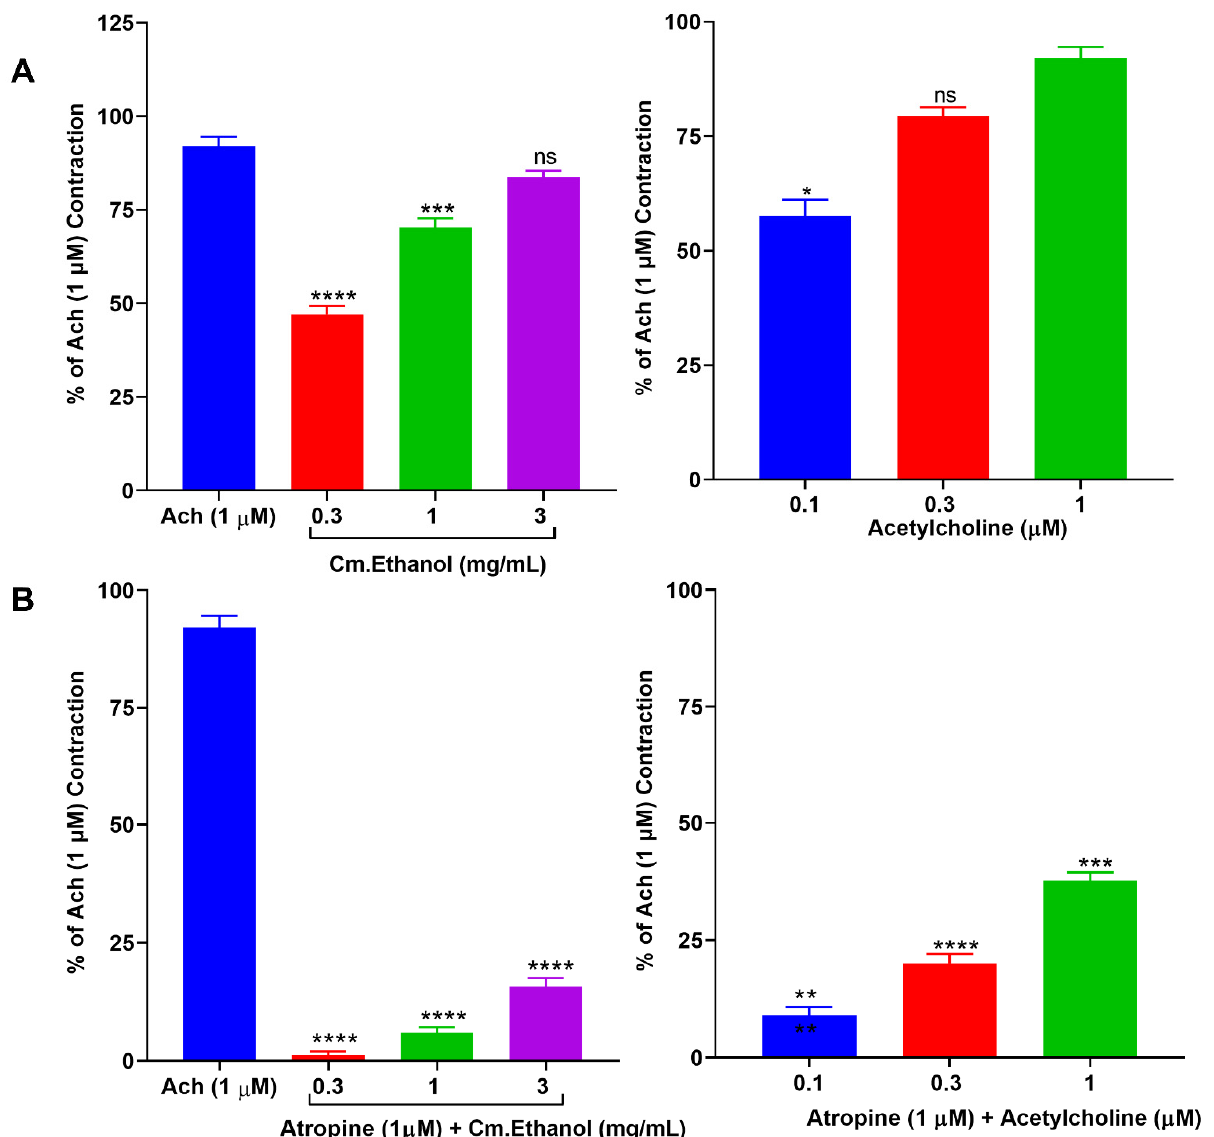
Figure 1. Cm–ethanol and acetylcholine (Ach) were tested in the ( A ) absence and the ( B ) presence of atropine in the ileum preparations of rats. Data are expressed as the mean ± S.D. ( n = 4). A Student’s t –test was performed to determine significance when compared to Ach: p < 0.05, * p < 0.01, ** p < 0.001, *** p < 0.0001, **** p < 0.00001 were used to determine significance.